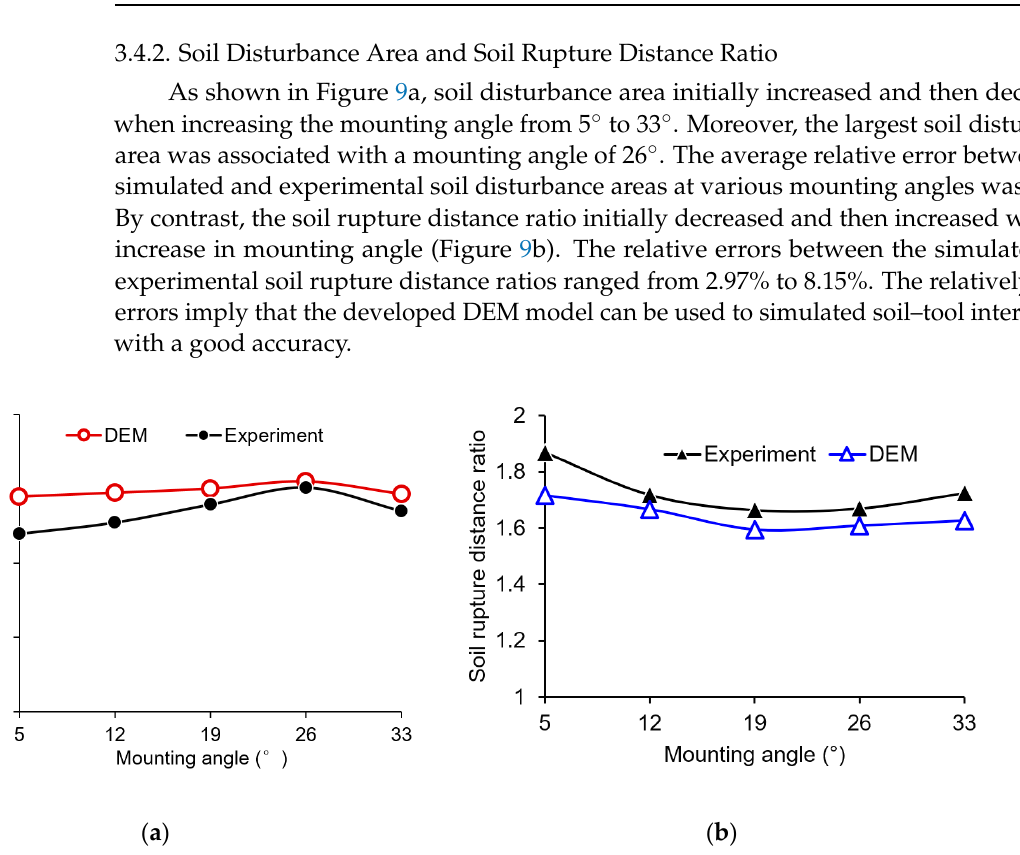
Figure 10. Draft forces of the bending subsoiling tool as affected by mounting angle. Soil loosening efficiency (SLE) is generally defined as the ratio of soil disturbance area to draft force [25]. The laboratory soil bin tests showed that SLEs were 42.29, 45.34, 50.04, 49.57 and 40.19 mm 2 N − 1 for BSTs with mounting angles of 5°, 12°, 19°, 26° and 33°, respectively. The comparably higher SLEs were associated with mounting angles of 19° and 26°. The above analyses indicate that appropriately increasing the mounting angle can improve the soil loosening efficiency of bending subsoiling tools without seriously in- creasing the draft force and soil surface flatness.